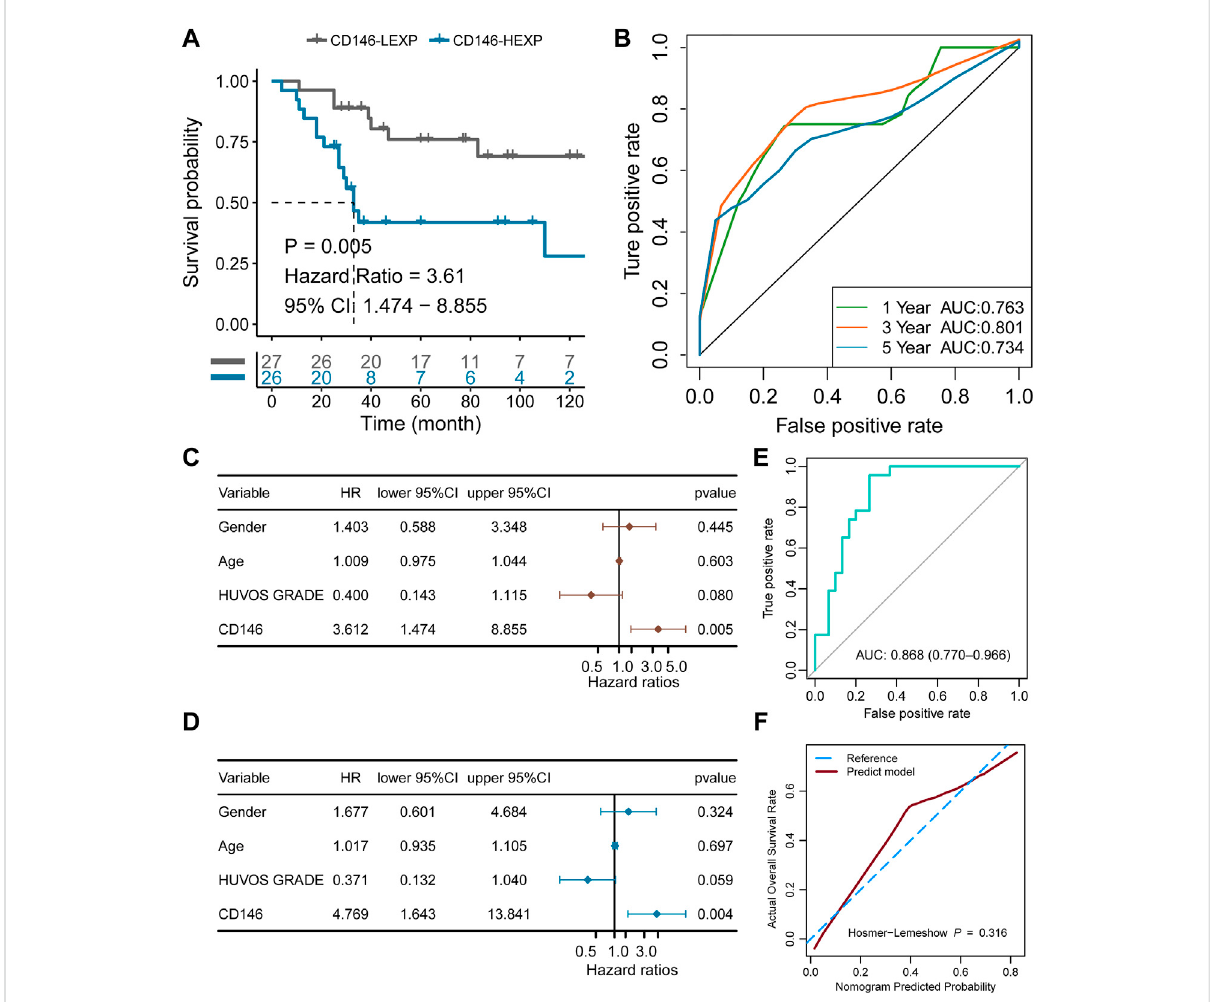
FIGURE 7 Validation of the independent prognostic value of CD146 in the external GSE21257 cohort. (A) K-M plot showing the diverse clinical overall survival outcomes of the CD146 low and high groups. (B) ROC curve showing the prognostic value of the CD146 expression level. (C) Results from univariateCoxregressionanalysisoftheCD146groupandclinicalfeatures. (D) ResultsfrommultivariateCoxregressionanalysisoftheCD146group and clinical features. (E) Validation of the nomogram by ROC curve in GSE21257 cohort. (F) Validation of the nomogram by calibration curve in GSE21257